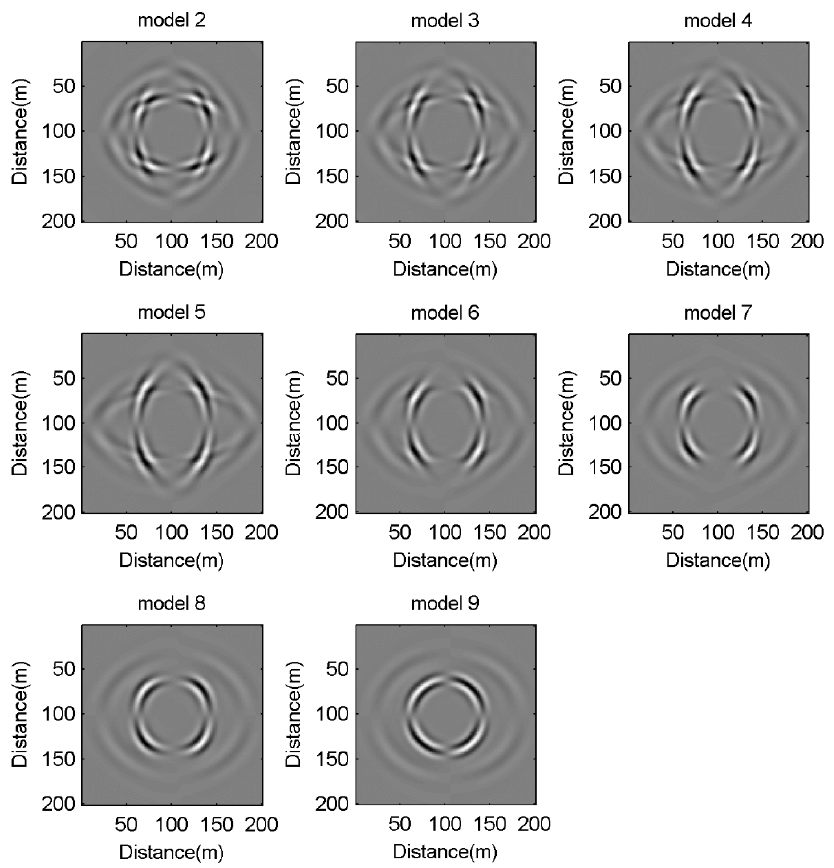
R generated from the expansion source at 0.05 s. Figure 6. Wave field snapshots of R y generated from the expansion source at 0.05 s. y